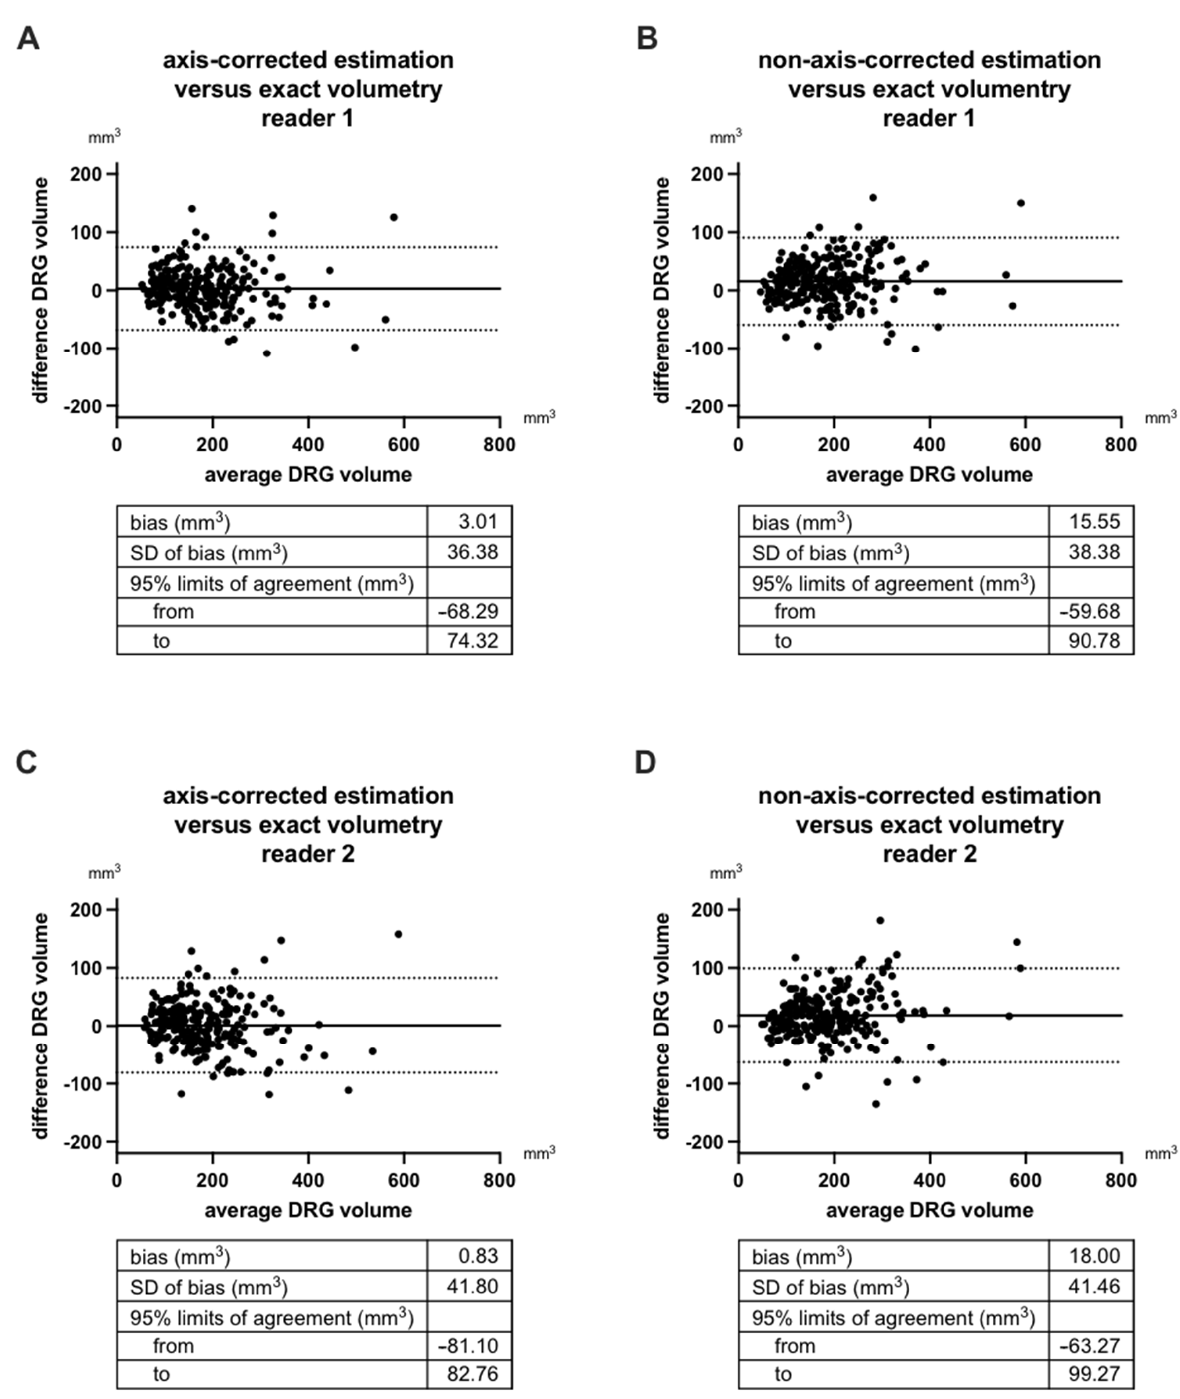
Figure 6. Bland–Altman plots of inter-method reliability comparing axis-corrected estimation with exact volumetry and non-axis corrected estimation with exact volumetry in reader 1 ( A , B ) and reader 2 ( C , D ). Positive values of difference DRG volume indicate overestimation, negative values indicate underestimation of DRG volume by the estimation formula when compared with exact volumetry. DRG = dorsal root ganglion. SD = standard deviation.